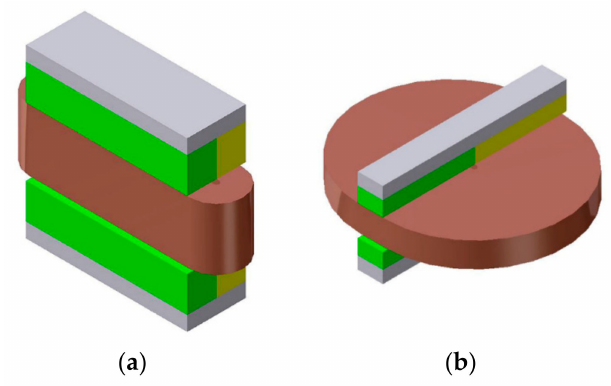
Figure 4. Extreme variations of HVCM with the same volume, ( a ) Lengthwise expansion, ( b ) Widthwise expansion. Table 3. Properties of the NdFeB magnet.